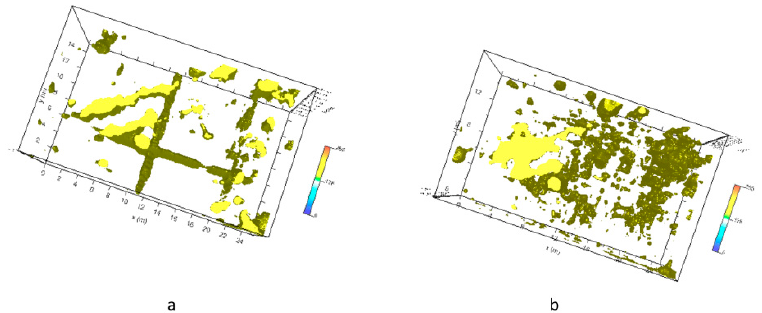
Figure 11. Plaza de Armas: sector 2: three-dimensional amplitude: ( a ) 600 MHz antenna; ( b ) 200 MHz antenna.